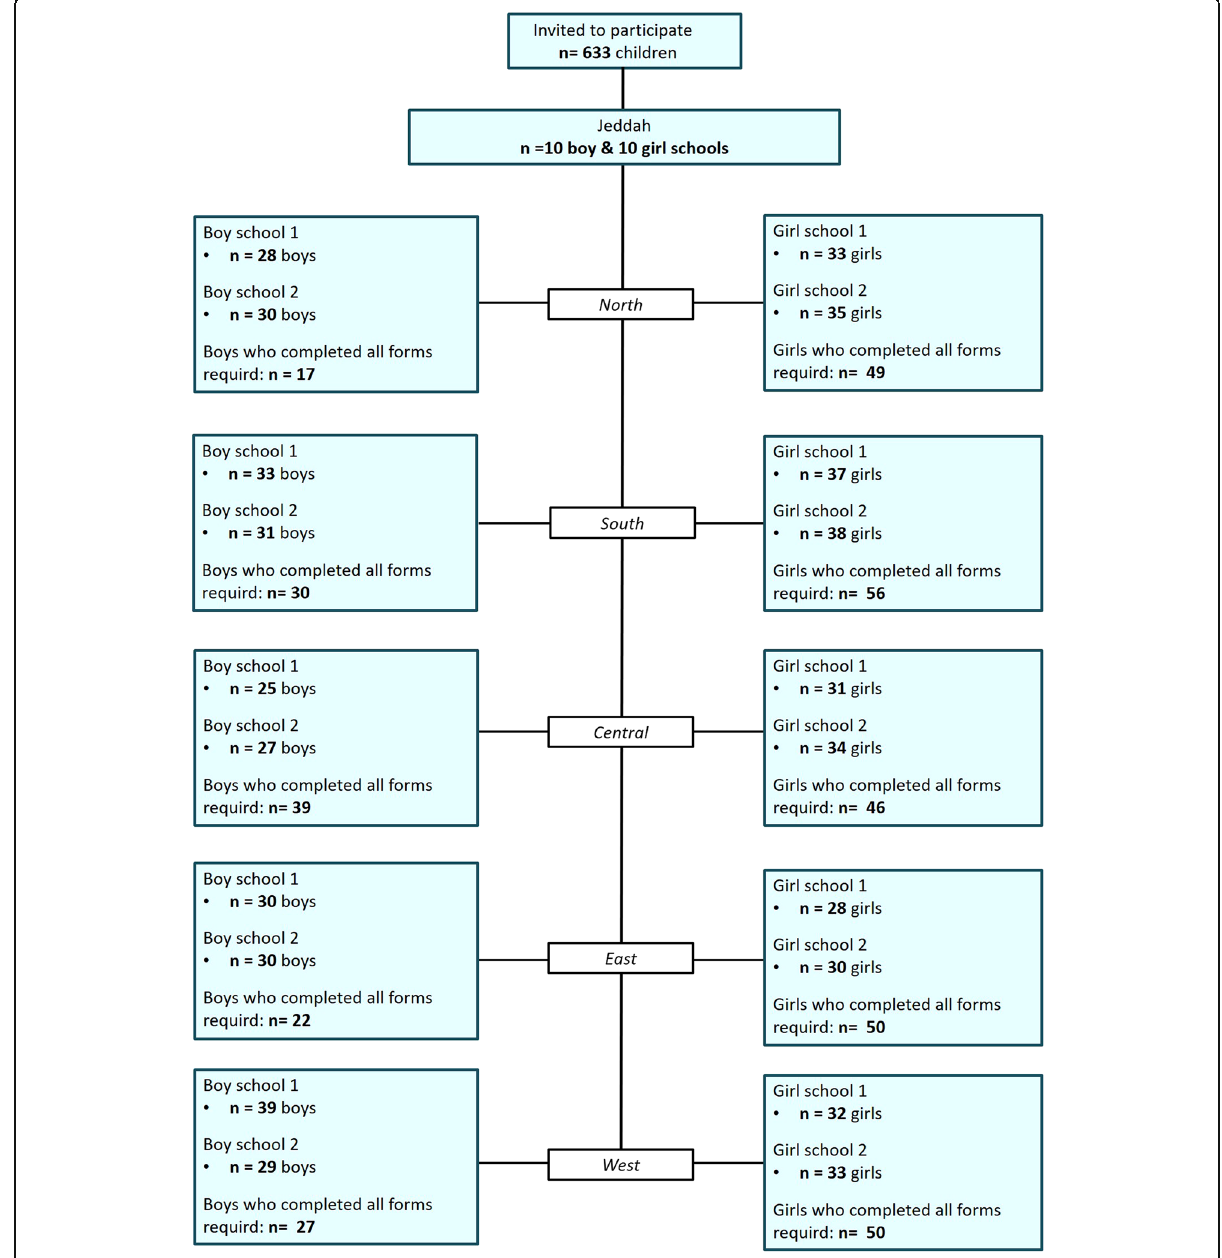
Fig. 1 Flowchart diagram showing the distribution of 386 children and adolescents, Jeddah, Saudi